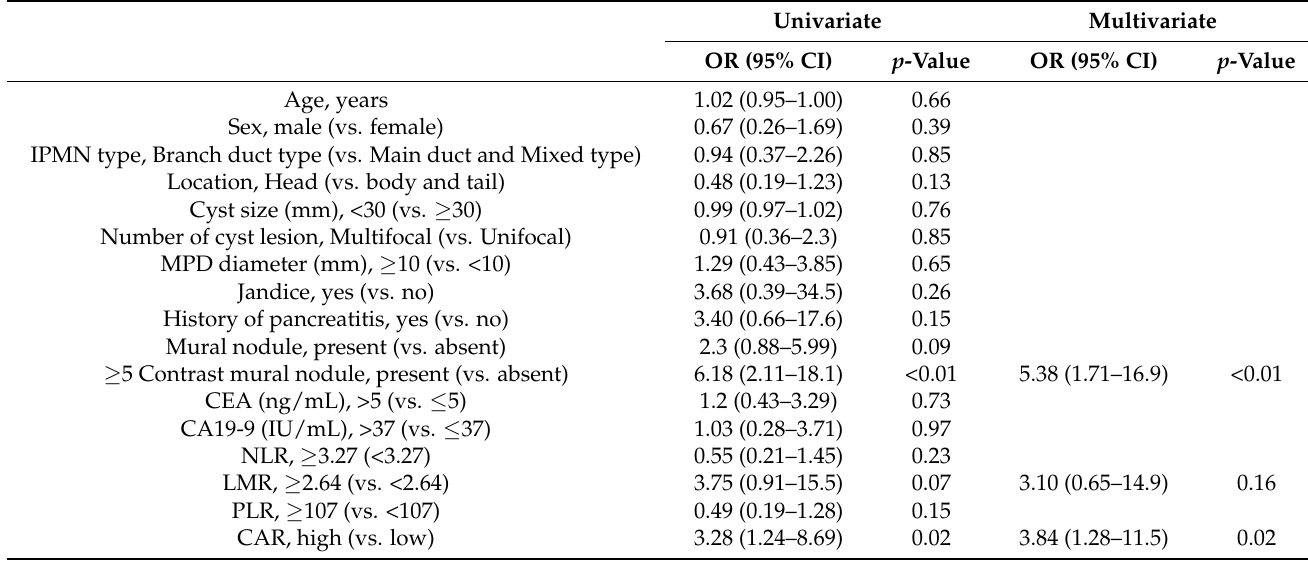
Table 3. Predictive factors for IPMN with HGD/INV.